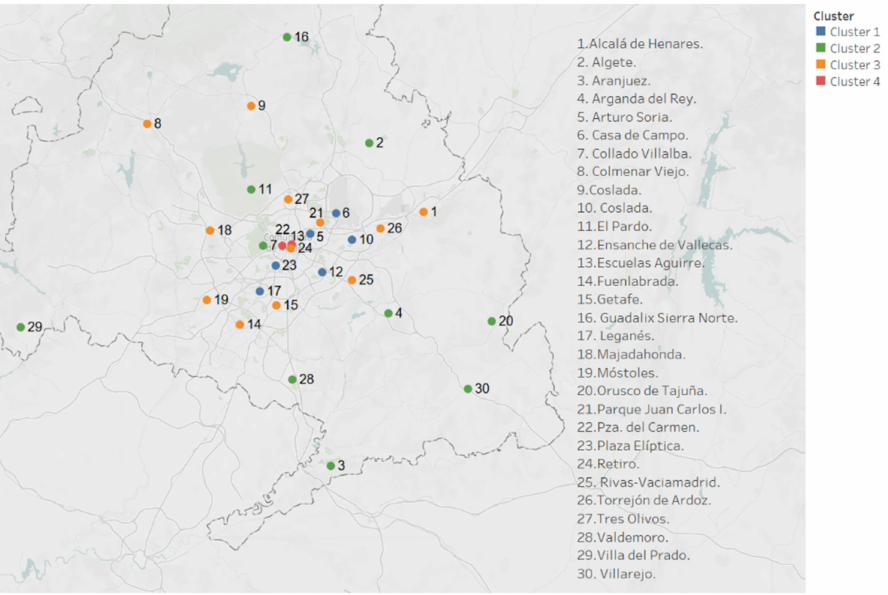
Figure 7. Cluster result considering pollutants NO, NO 2 , and O 3 . Cluster 2 (green color points on the Figure 7) identifies basically the areas with very low emission levels due to limited traffic; among them, we included rural settlements and metropolitan areas with abundant vegetation, such as Casa de Campo and El Pardo. This means that declines in NO and NO 2 were lower and, consequently, the rise in O 3 was less pronounced than in Cluster 1 (by 13% on average). Cluster 3 (orange color points on the Figure 7) detects the northeast of the CM, charac- terized by significant percentual falls in NO and NO 2 (by 24.7% and 51%, respectively). In Cluster 4 (red color points on the Figure 7), two areas stand out: Escuela Aguirre and Plaza El í ptica, both with a very heavy traffic under normal circumstances, where the LD led to a plunge in NO levels by 150.8% on